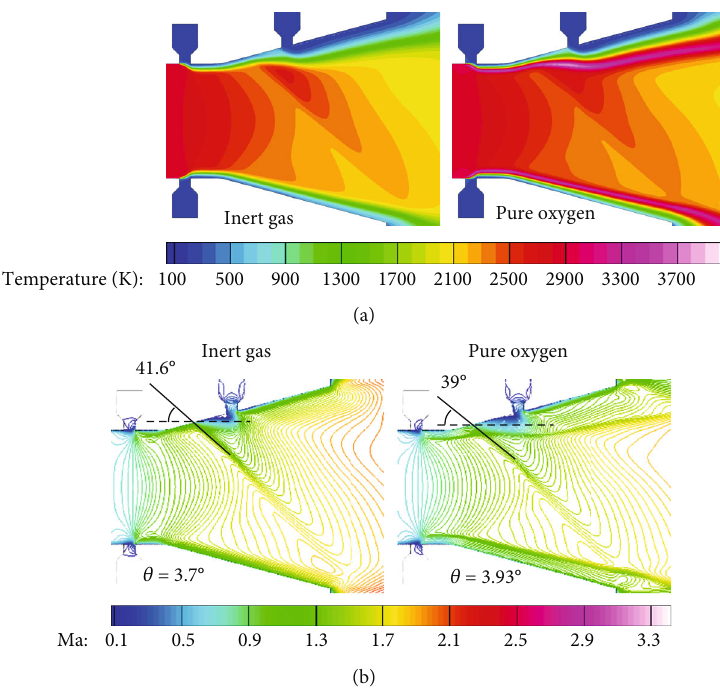
Figure 18: Contour of fl ow fi eld injected in the divergence section and the throat: (a) temperature contours; (b) Mach contours.